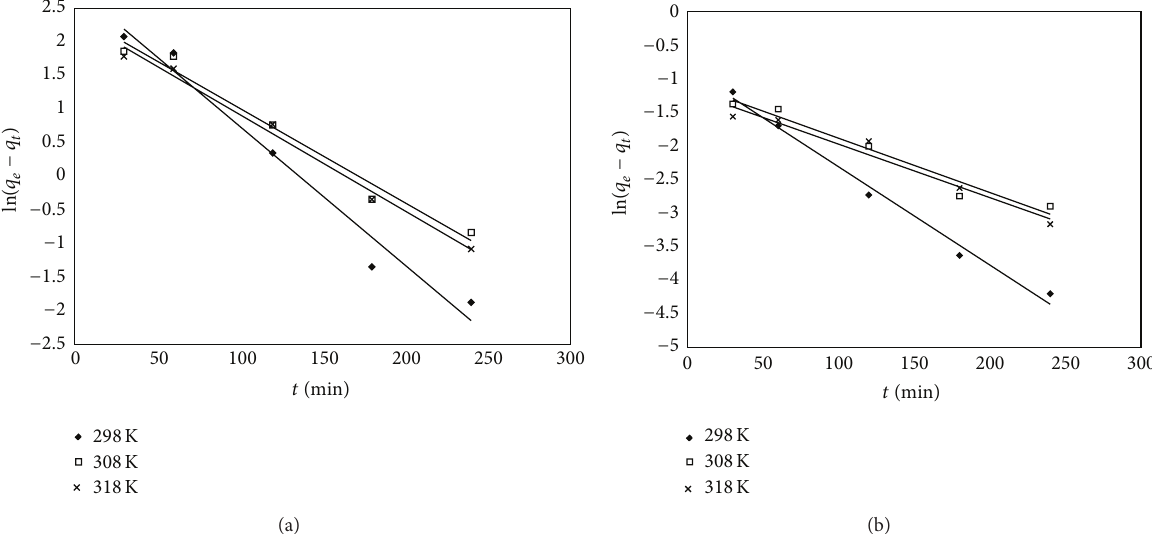
Figure 6: Pseudo-first-order kinetic plots for silica (a) and florisil (b) at the adsorption of As(V).